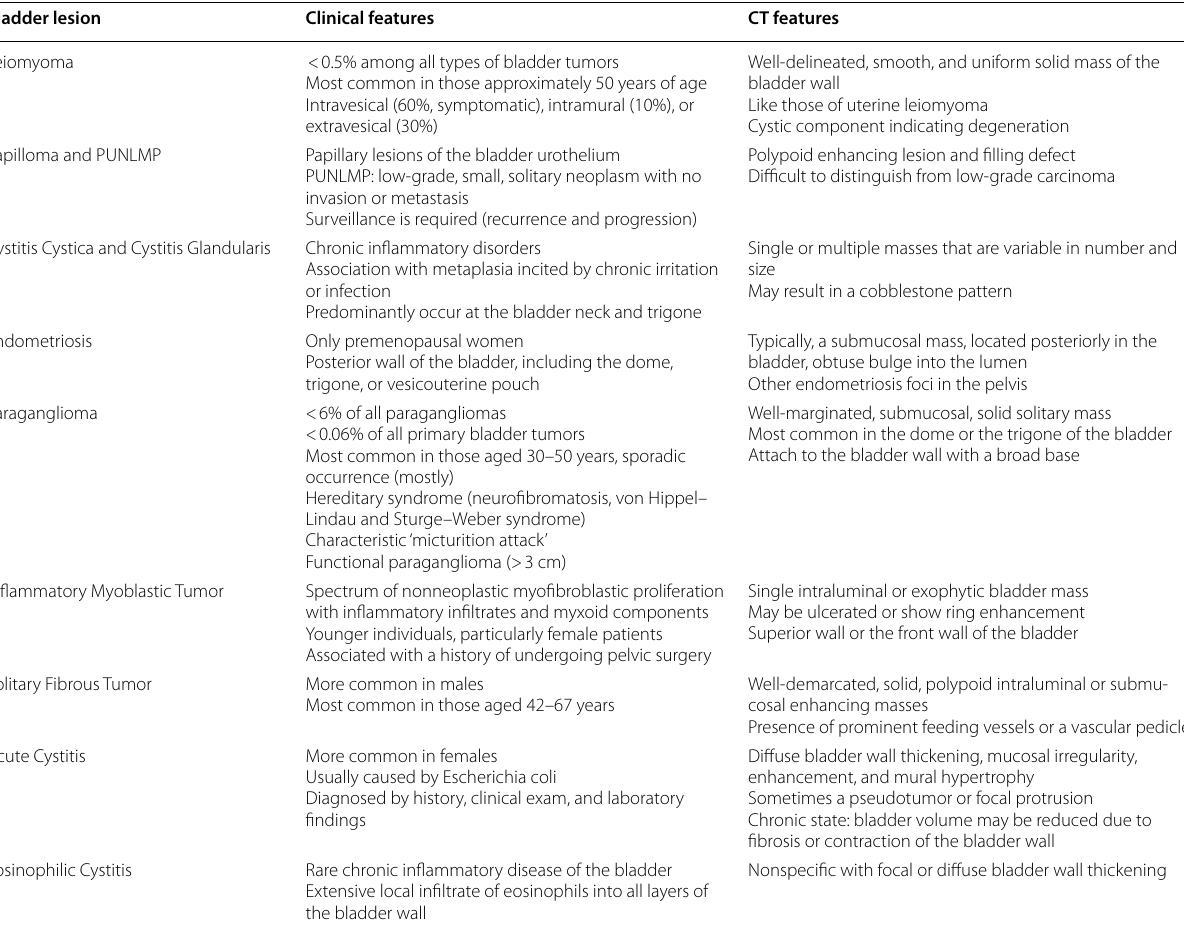
Table 3 Summary of the clinical and CT features of benign bladder lesions Bladder lesion Clinical